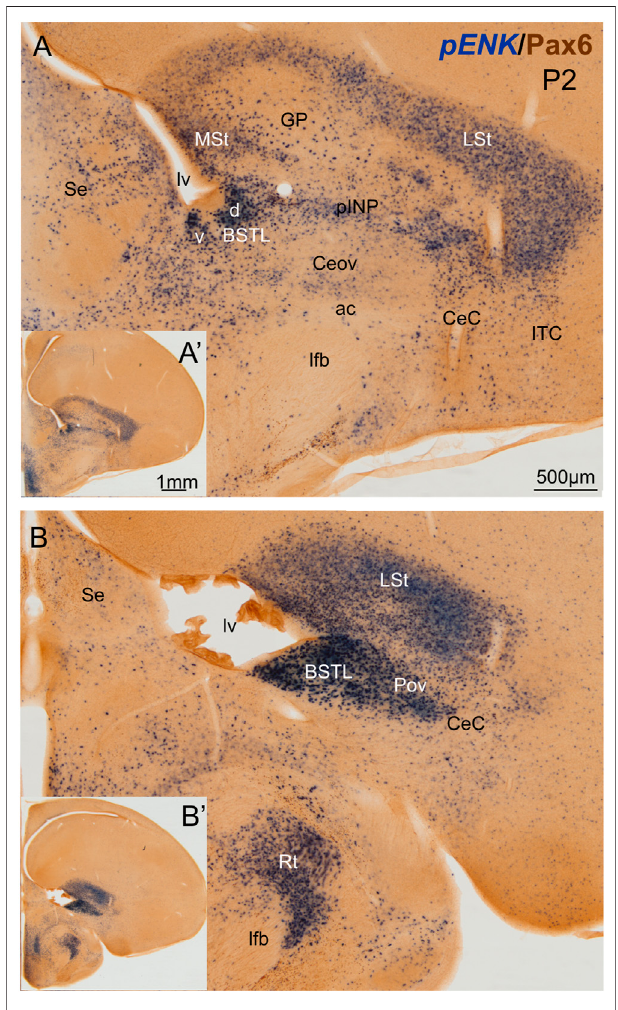
FIGURE1 | Chromogenic doublelabeling ofpro-enkephalin ( pENK ) and Pax6 in the chicken central extended amygdala at P2. (A,B) Details of the subpallium, with the central extended amygdala, taken from frontal sections (insets) of the chicken embryonic telencephalon, at commissural (A) and post-commissural (B) levels, hybridized for pENK (blue color) and immunostained for Pax6 (brown color). Note the high amount of pENK cells in theBSTLandpINP.BothareasalsocontainmanyPax6cells,whicharebetter appreciated in the fl uorescent images ( Figures 2 , 5 , 7 ). See text for